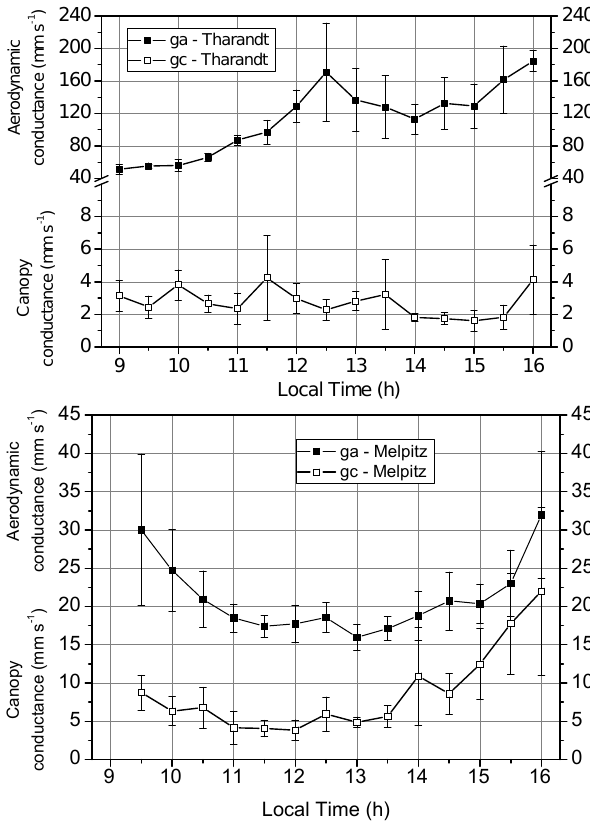
Fig. 10. Course of aerodynamic and canopy conductance at the An- chor Station Tharandt (panel above) and at the Melpitz experimental site (panel below) for the investigation period 18 to 21 June 2000 (ensemble mean and error bars from 09:00 to 16:00LT). simulations and measurements match also sufficiently. The highest simulated differences of (cid:127) for the two contrast- ing land uses occur with 0.67 in the afternoon ( (cid:127) min for spruce: 0.04 from simulation-2 and (cid:127) max for grass: 0.71 from simulation-3). During the morning hours there is even a change of ranking between the extreme omega values for the grass ( (cid:127) min =0.23 from simulation-2) and the spruce site ( (cid:127) max =0.26 from